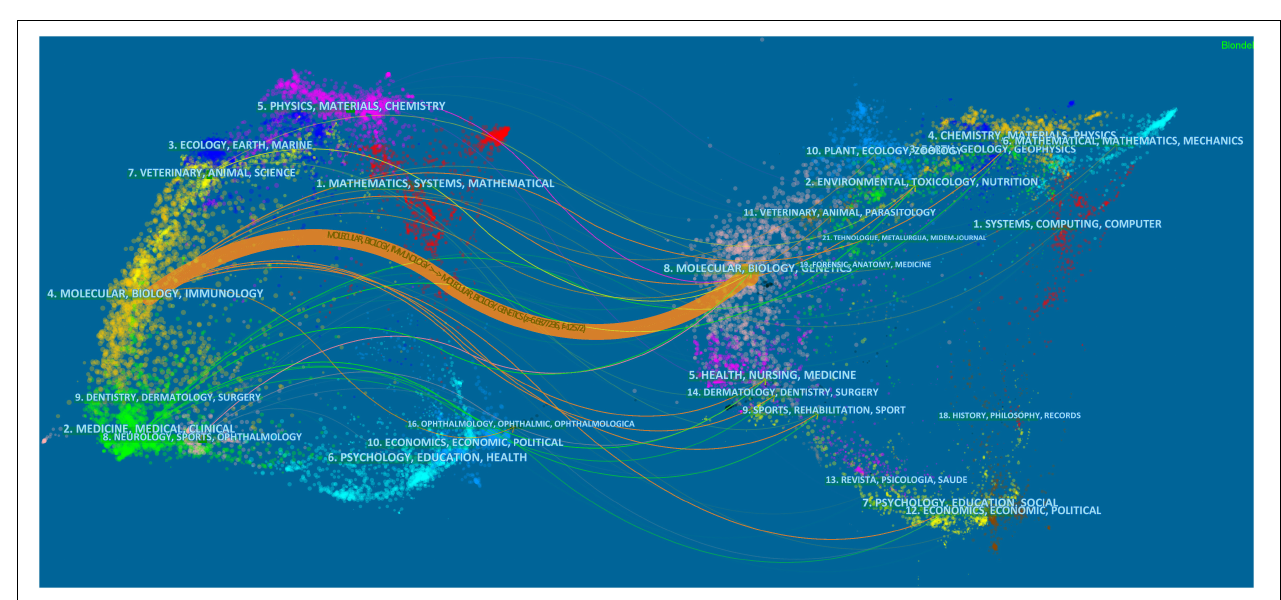
FIGURE 2 | The dual-map overlay of journals that published articles on the crosstalk between microRNAs and circular RNAs.